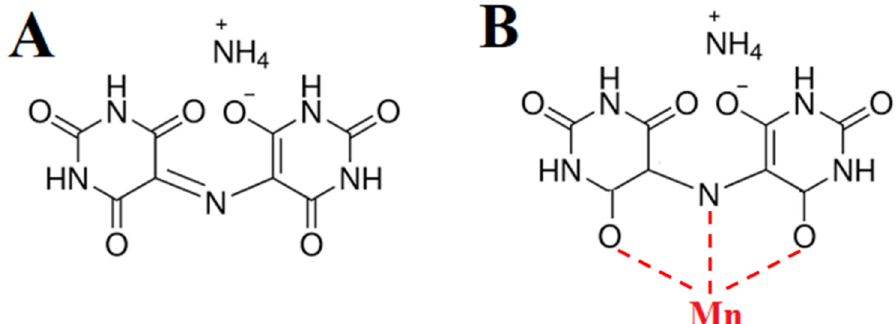
Figure 2. ( A ) Chemical structure of murexide, ( B ) adsorption of murexide on particle, involving tridentate chelation of surface Mn atoms.